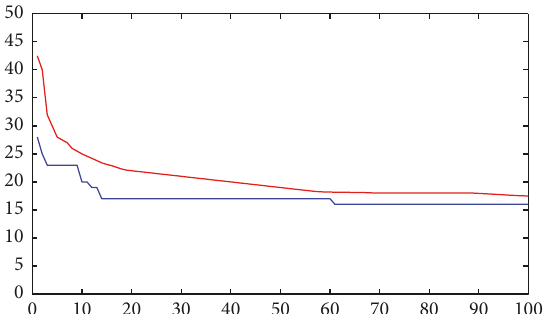
Figure 11: Evolutionary curve obtained by proposed initializing